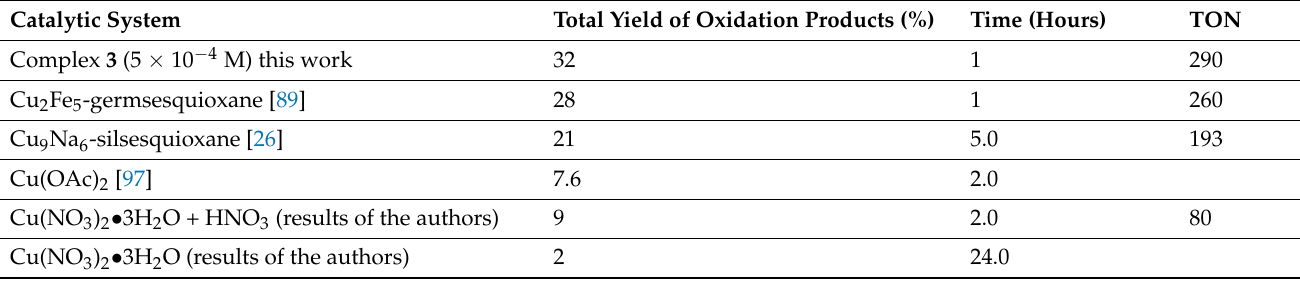
Table 1. Comparison of catalytic efficiency of copper-based catalysts including complex 3 .